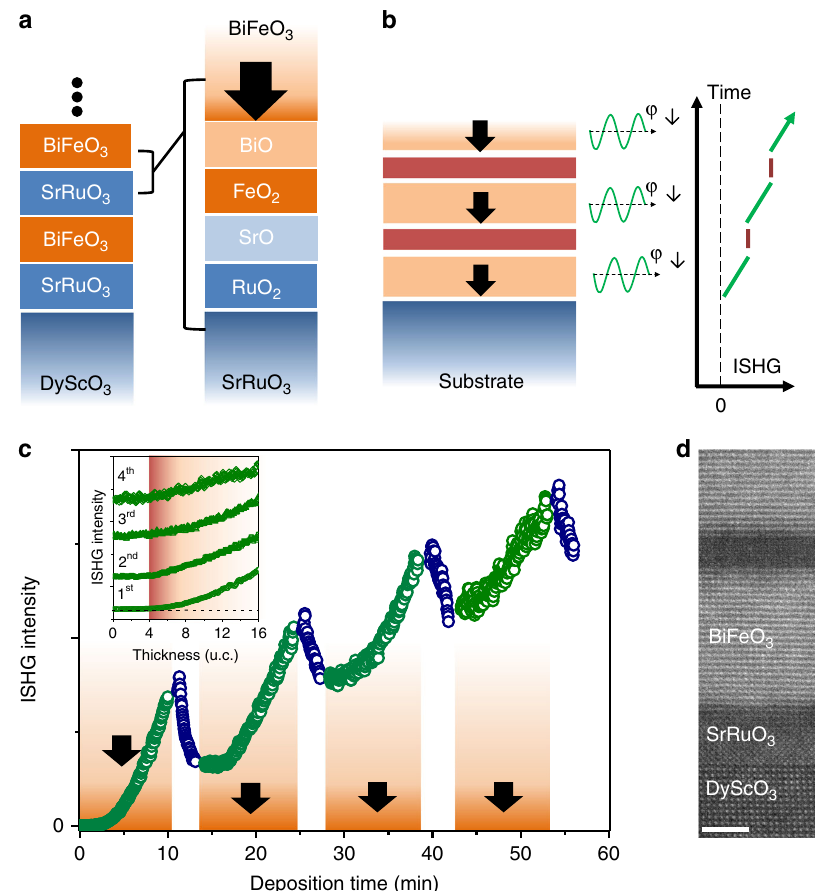
Fig. 3 Engineering ferroelectric multilayers with user-de fi ned up/down polarization sequence I. a B-site growth and downwards polarization of BiFeO 3 (BFO) is achieved by SrO self-termination of the SrRuO 3 (SRO). b Ferroelectric multilayer as in ( a ), assuming a uniform orientation of the polarization in all layers. This should lead to repetitive increase of the in situ second harmonic generation (ISHG) yield because of constructive interference of the ISHG waves emitted from each layer (indicated by the uniform ISHG phase φ ↓ ). c ISHG on a sequence of BFO | SRO multilayers. All the BFO layers (20 unit cells, ISHG as green open circles) grow with downward polarization, evidenced by continuous increase of the ISHG intensity from the BFO. During SRO deposition (10 unit cells, ISHG as blue open circles) the signal decreases because of linear absorption. The inset with vertically displaced curves emphasizes the identical critical thickness at which the polar state emerges in all the BFO layers. d Scanning transmission electron microscopy image in the high-angle annular dark- fi eld mode con fi rms the high interfacial quality of the multilayer structure with no visible interdiffusion. The scale bar corresponds to 3